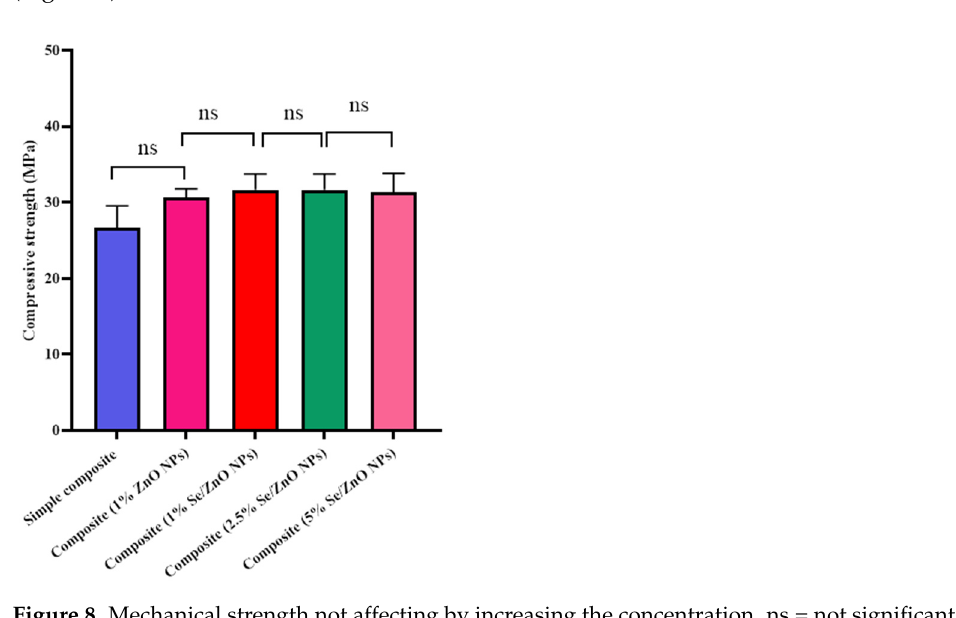
10 of 14 Figure 7. Hemolytic activity of resin composite ZnO NPs and Se/ZnO NPs. ( a ) Supernatant does not show any hemolysis of RBCs except positive control that shows 100% hemolysis of RBCs and ( b ) statistically significant reduction in hemolysis ( p < 0.005). In quantitative analysis (Figure 7b), the OD of the supernatant was obtained at 545 nm in UV-Vis spectroscopy, and % hemolysis was calculated. It was found that composite materials with Se/ZnO NPs at all concentrations do not have any hemolytic activity as their values lie in the non-hemolytic range, which is less than 5% for materials defined by the ASTM F756 standard. Our positive control (blood with Triton X-100) showed 100% hemolysis, whereas the negative control (PBS solution with blood) had 0% hemolytic ac- tivity. The simple composite showed 0% hemolytic activity, and the composite with pris- tine 1% ZnO NPs showed 5.1% hemolysis that does not fall under the safe range according